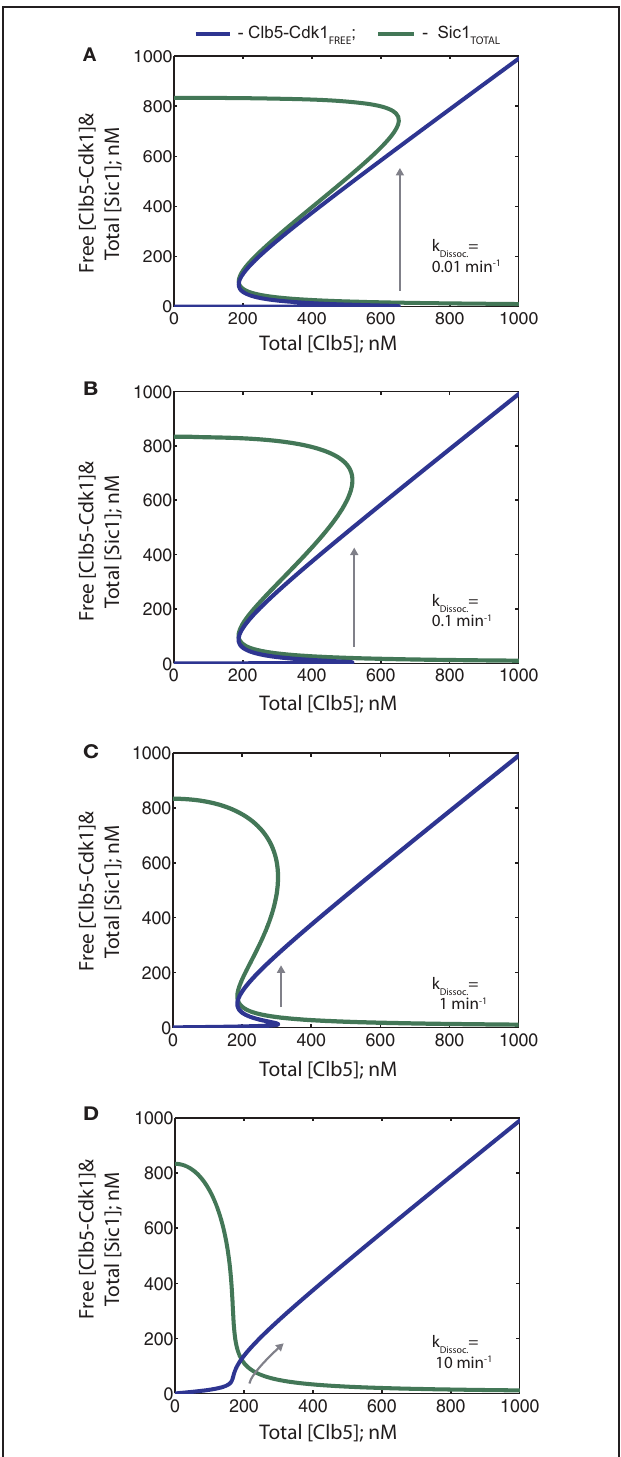
FIGURE 5 | (A–D) The steady state phase diagrams showing the effect of the inhibition strength on the bistability of the G1/S switch. The dissociation rates of the inhibitory complex were increased in 10-fold increments from 0.01 to 10min − 1 as indicated. In the model, these values correspond to K i values of 0.1–100nM. Arrows indicate the paths of the system at the G1/S